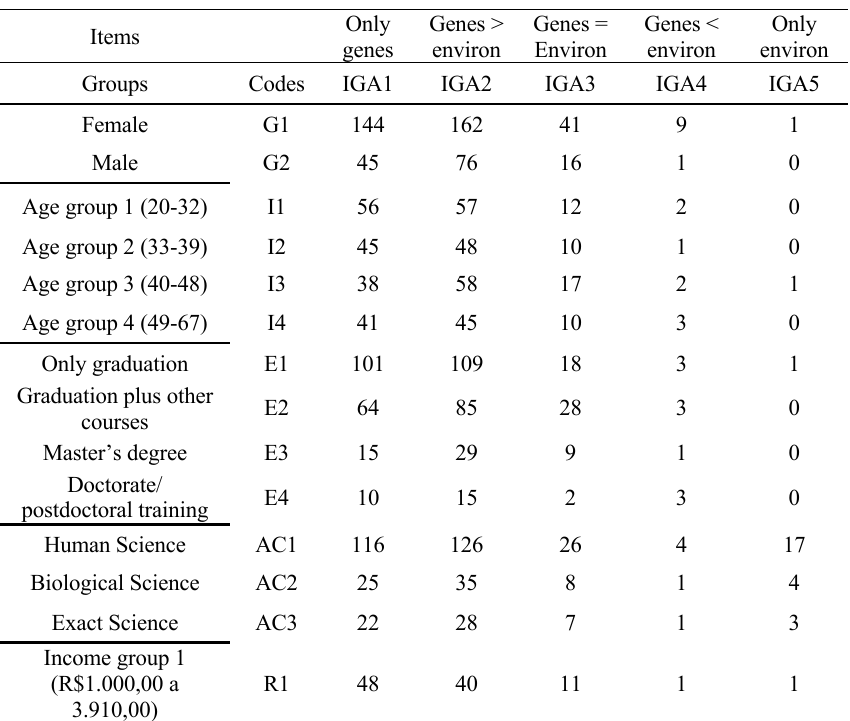
Frequency of groups’ responses to question 1 regarding genetic and environmental influences on mental disorders